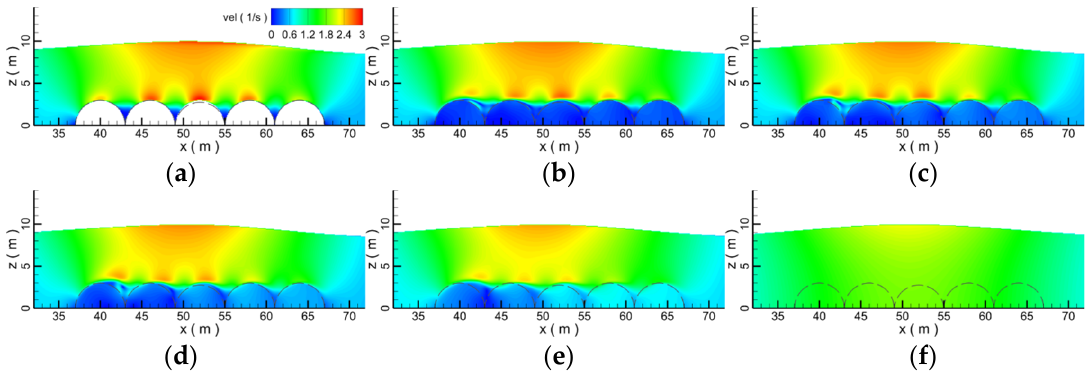
Figure 7. The velocity contour of the wave peak on the breakwaters under different porosities; ( a ) por = 0.0; ( b ) por = 0.2; ( c ) por = 0.4; ( d ) por = 0.6; ( e ) por = 0.8; ( f ) por = 1.0.